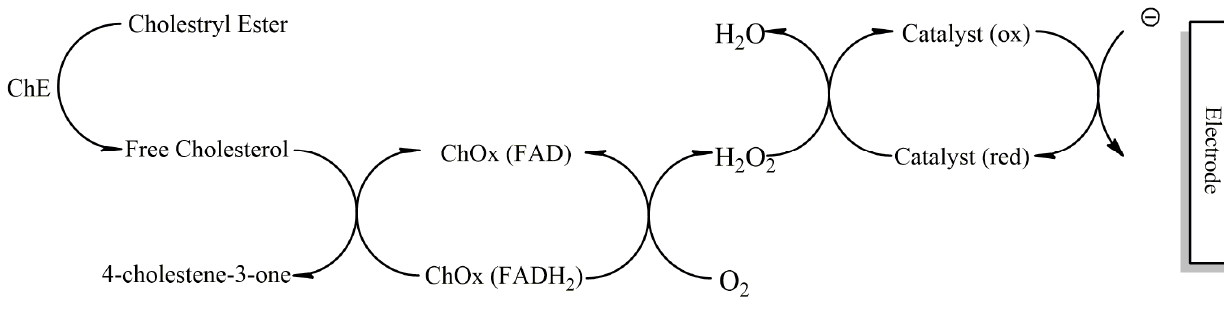
Figure 8. A schematic showing an immobilized enzyme biosensor (adapted from [96]). Commercial cholesterol biosensors: CardioChek Cholesterol meter and Cholesterol Biometer cholesterol (Polymer Technology Systems,